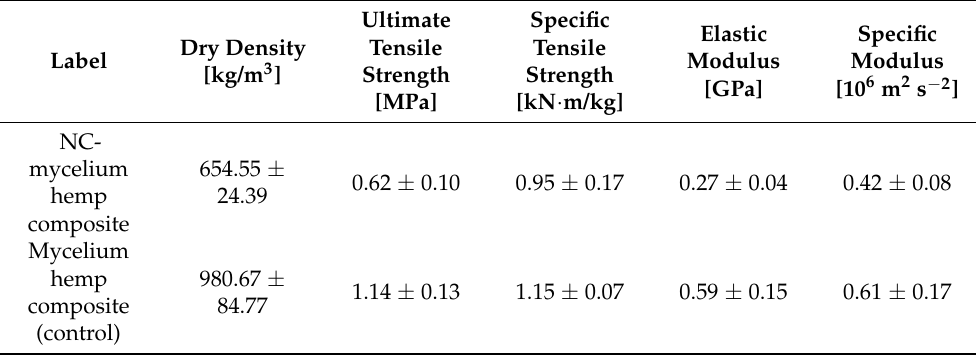
Table 3. Overview of the material properties in internal bond of nanoclay–mycelium composites. The standard deviation is performed with 9 specimens (mean ± one standard deviation).